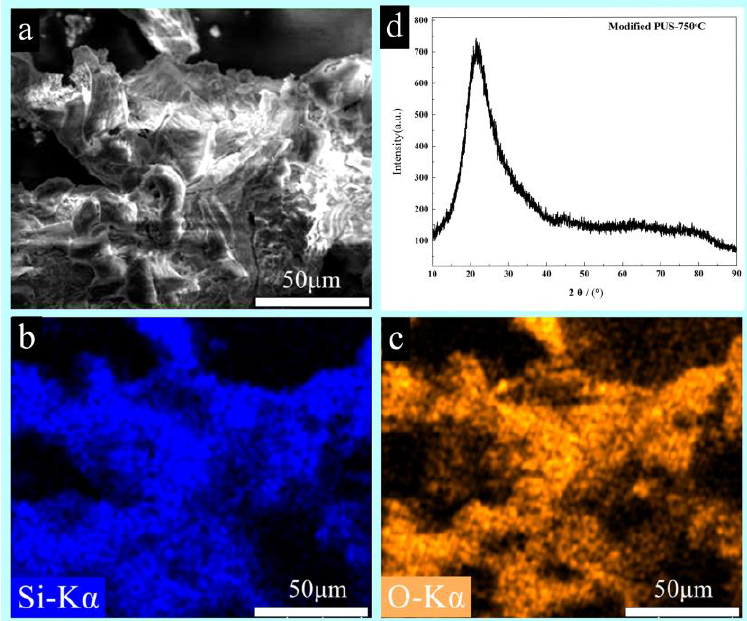
Figure 5. ( a – c ) The element mapping and ( d ) XRD pattern of the modified PUS at 750 °C.